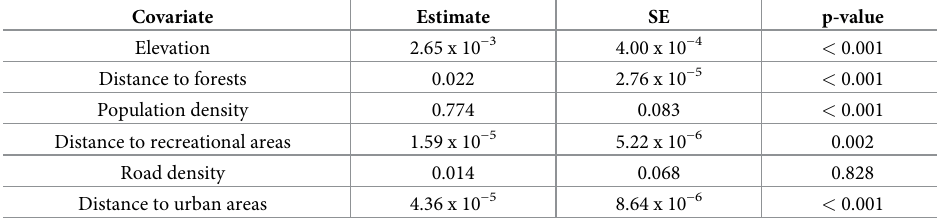
Table 3. Coefficient estimates for each parameter and its corresponding significance based on the optimal resource selection probability function model.